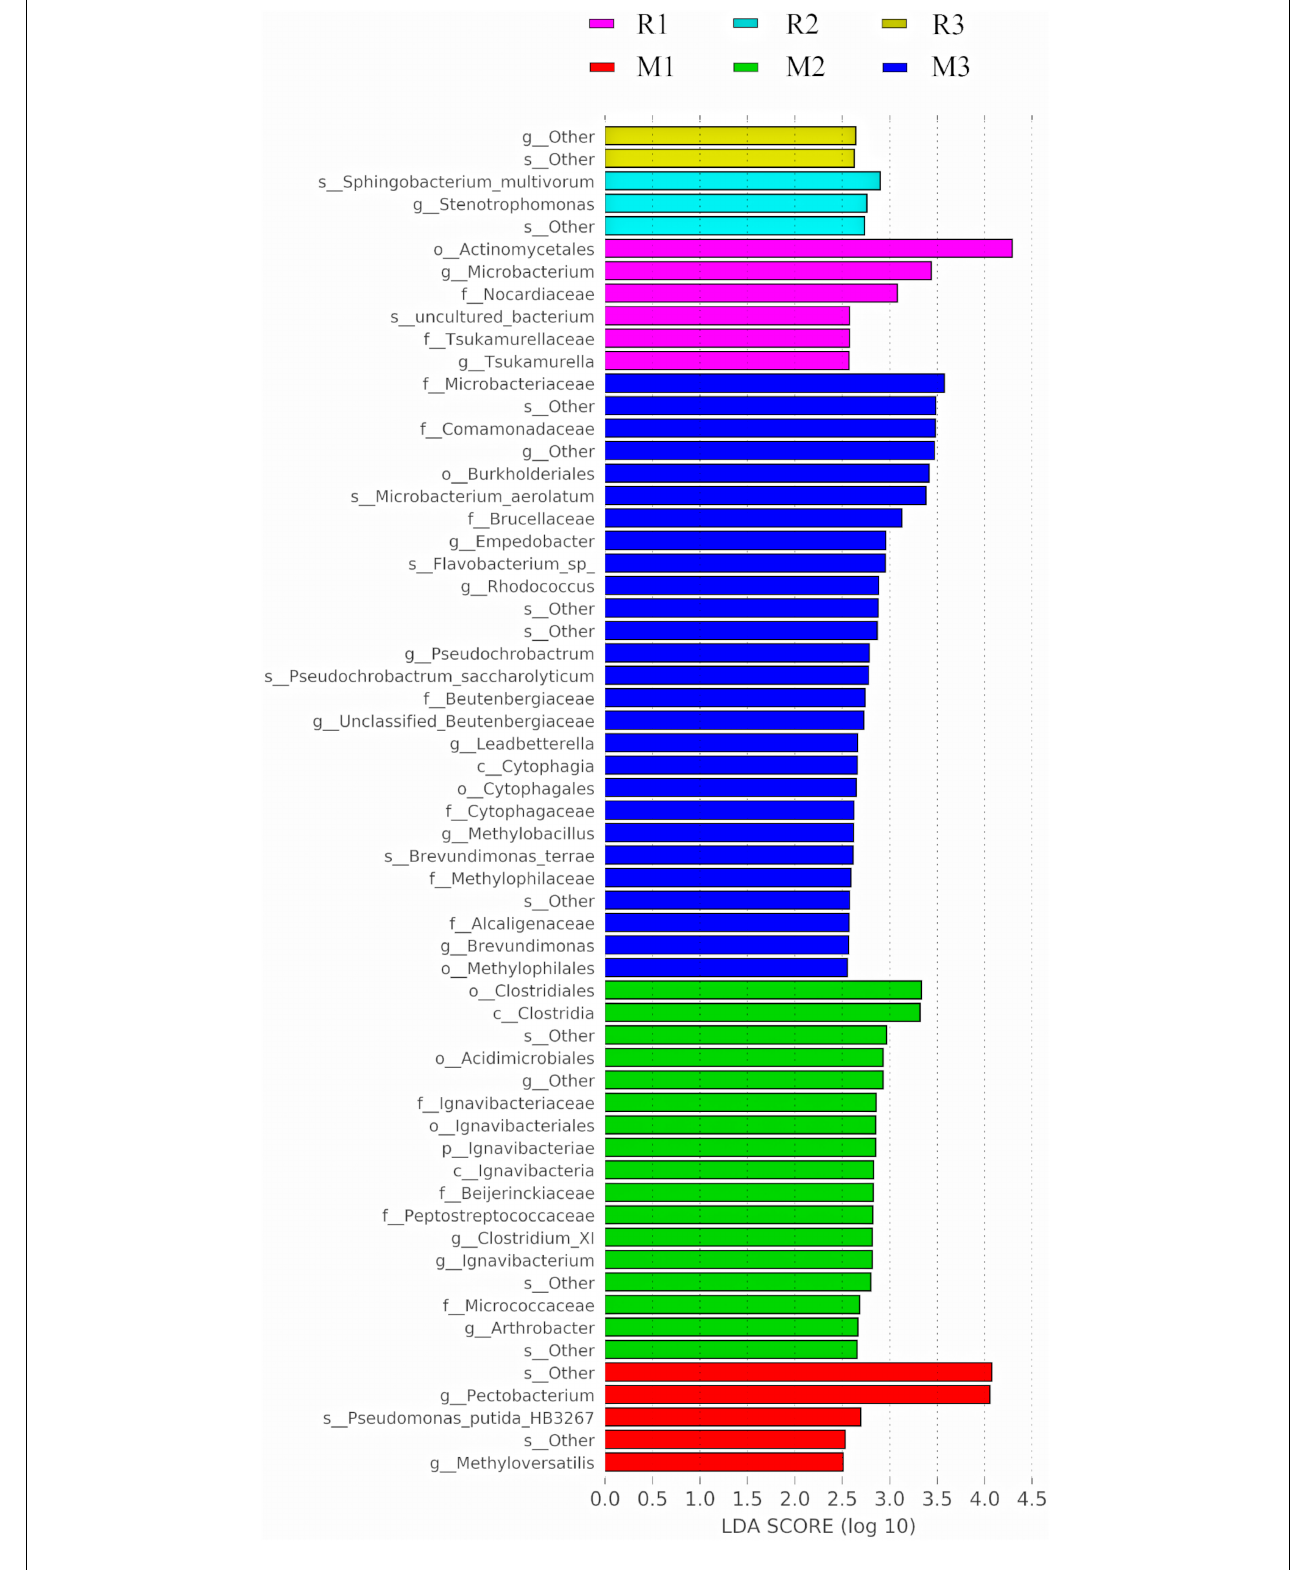
FIGURE 7 | Bacterial taxa with LDA scores greater than two in the gut microbiota of C. medinalis fed different host plants for three generations.